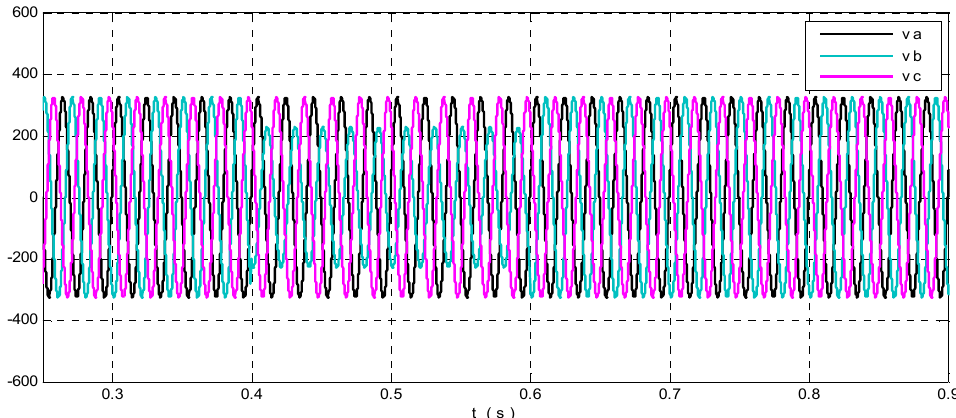
Figure 26. Voltage and current signals (phase a).